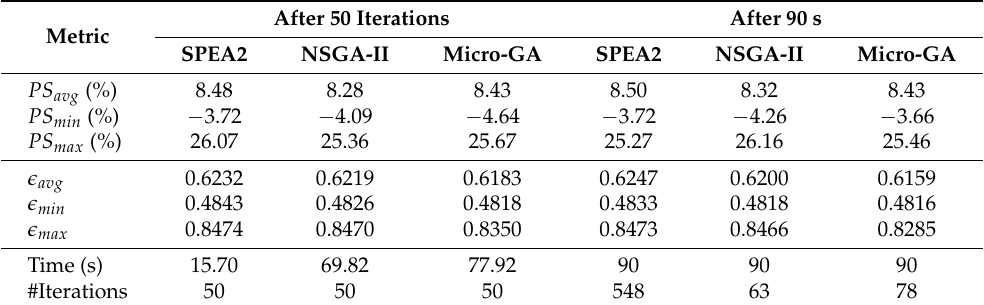
Table 10. Metrics evaluation for the three applied algorithms regarding both stopping criteria. After 50 Metric